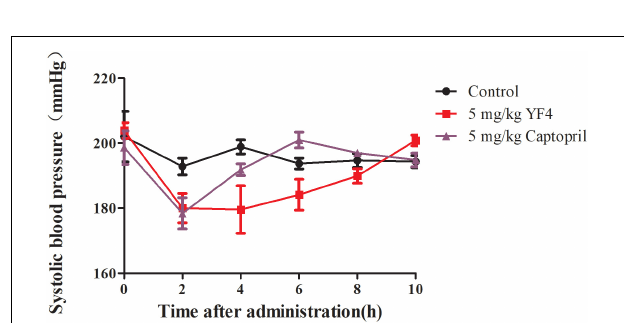
FIGURE 3 | Characterization of optimal YF4-LNPs. (A) TEM image of YF4-LNPs. (B) DSC curves of Free YF4, Blank LNPs, Blank LNPs, and YF4 mixture and YF4-LNPs. (C) Change in EE and size of YF4-LNPs in 2 weeks stored at 4 ◦ C.